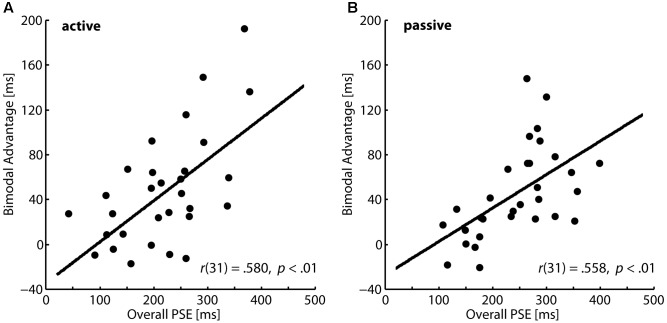
Correlations between average PSEs and the bimodal advantages in the temporal mismatch task. (A) Active condition and (B) passive condition.